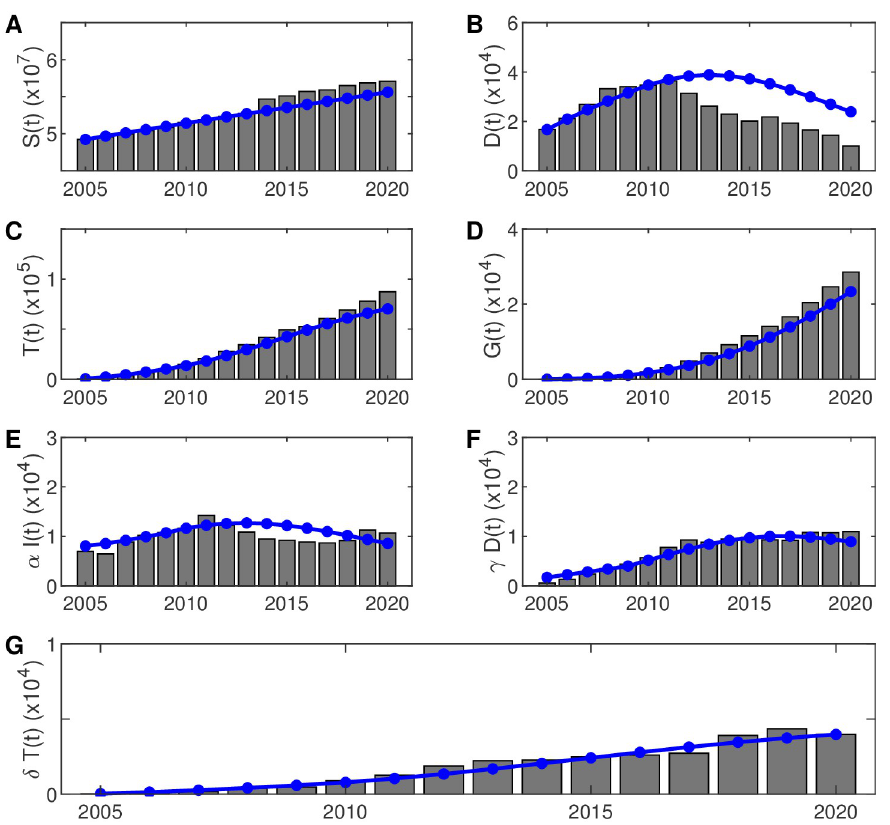
Fig 4. Comparison between model output and surveillance data. Fitting of simulation data (in blue) to statistical data (histogram) from 2005 to 2020. The histogram shows the annual susceptible individuals (A), the annual diagnosis individuals (B), the annual individuals under ART (C), the annual drop-outs of ART (D), the annual new diagnosis individuals (E), the annual new individuals under ART (F), the annual new drop-outs of ART (G). The models were well fitted between the simulated data and the surveillance data ( R 2 = 0.90). ART: Antiretroviral treatment.